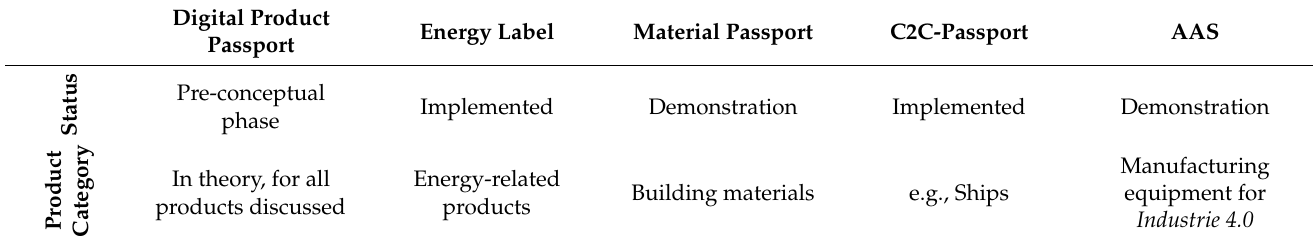
Table 1. Comparison of information